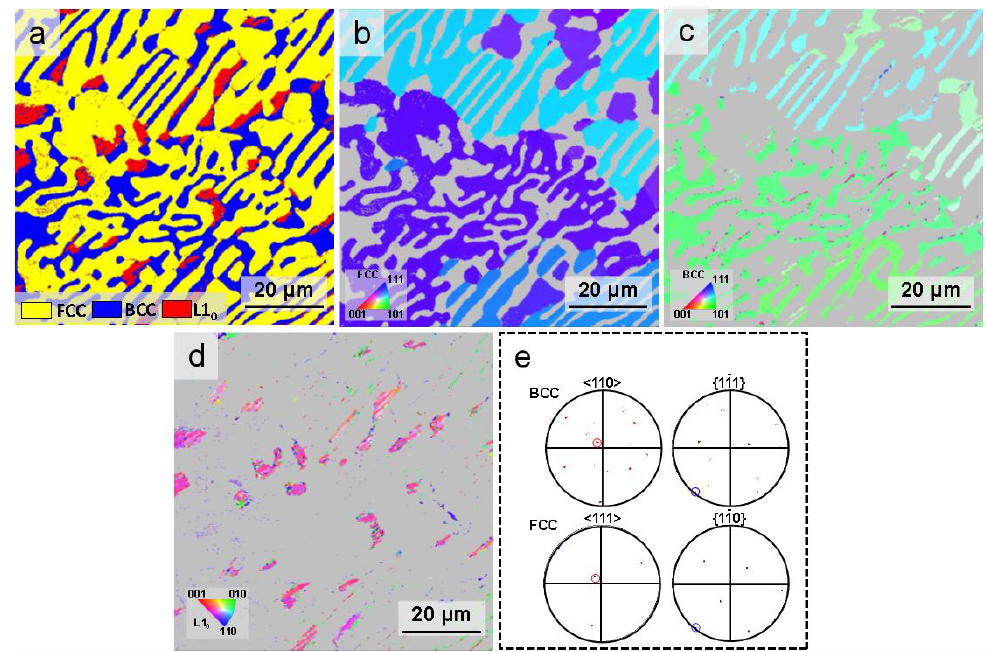
Figure 4. EBSD results of the as-cast Co 39.2 Ni 39.2 Al 21.6 EMEA. ( a ) Phase map; ( b ) IPF map of FCC phases; ( c ) IPF map of BCC phases; ( d ) IPF map of L1 0 phases; ( e ) pole figures of FCC and BCC phases in a single eutectic colony. The pole points on the (1-11) (blue circle) and [110] (red circle) pole figures of the BCC phase overlap with those on the (1-10) (blue circle) and [111] (red circle) pole figures of the FCC phase, implying the preferred orientation